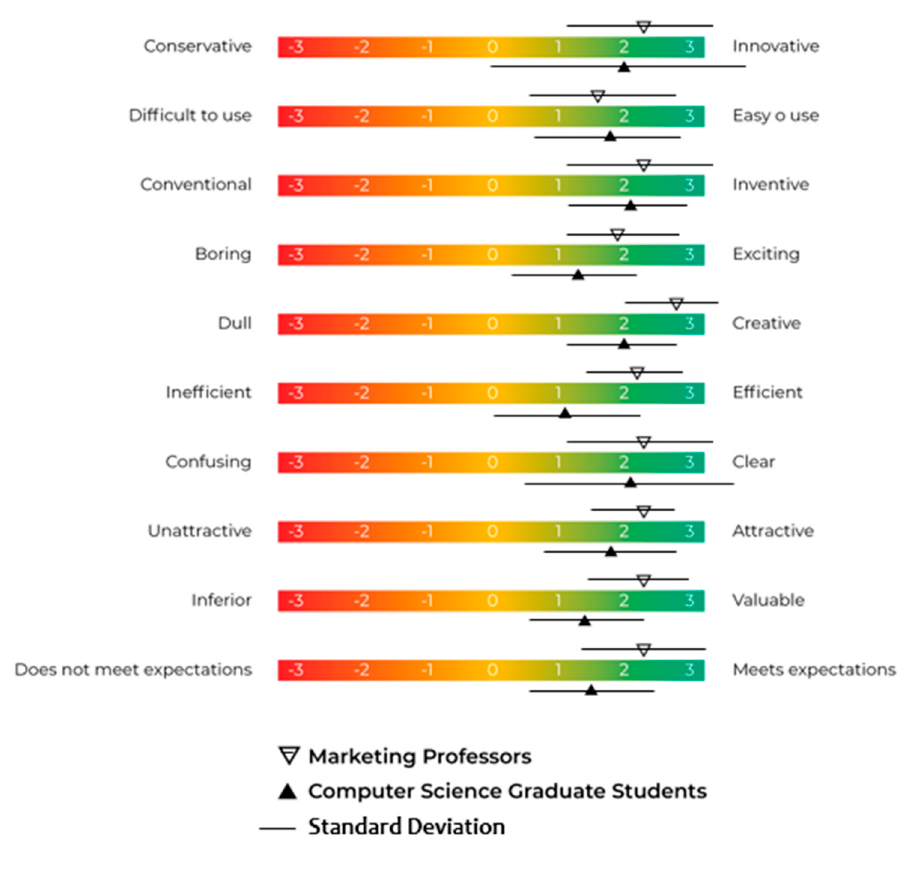
Figure 5. Storyboard Evaluation Results.